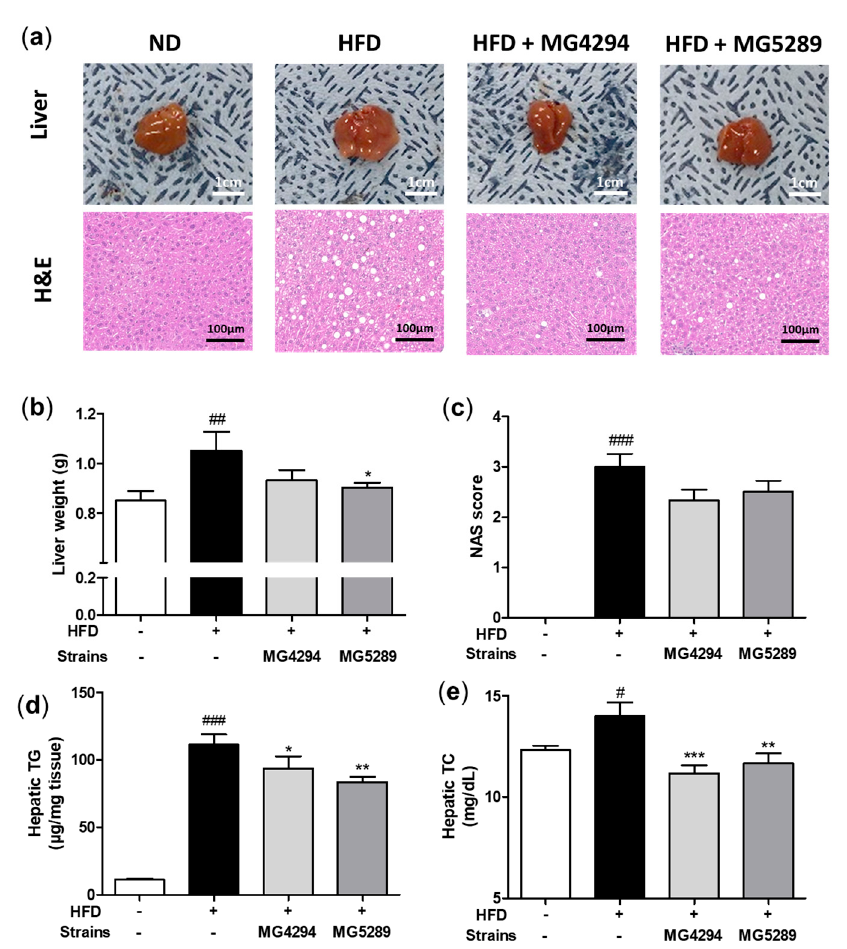
Figure 6. Treatment of L. fermentum MG4294 and L. plantarum MG5289 suppresses hepatic dysfunc- tions in HFD-induced mice. Representative images and microscopic H&E staining of the liver from different mice groups fed with HFD are shown ( a ). The liver weight ( b ) and NAS ( c ) were measured and calculated. Hepatic TG ( d ) and TC ( e ) were analyzed by ELISA kits. The data are expressed as mean ± SEM ( n = 6). # p < 0.05, ## p < 0.01, and ### p < 0.001 compared with ND group; * p < 0.05, ** p < 0.01 and *** p < 0.001 compared with HFD-group.